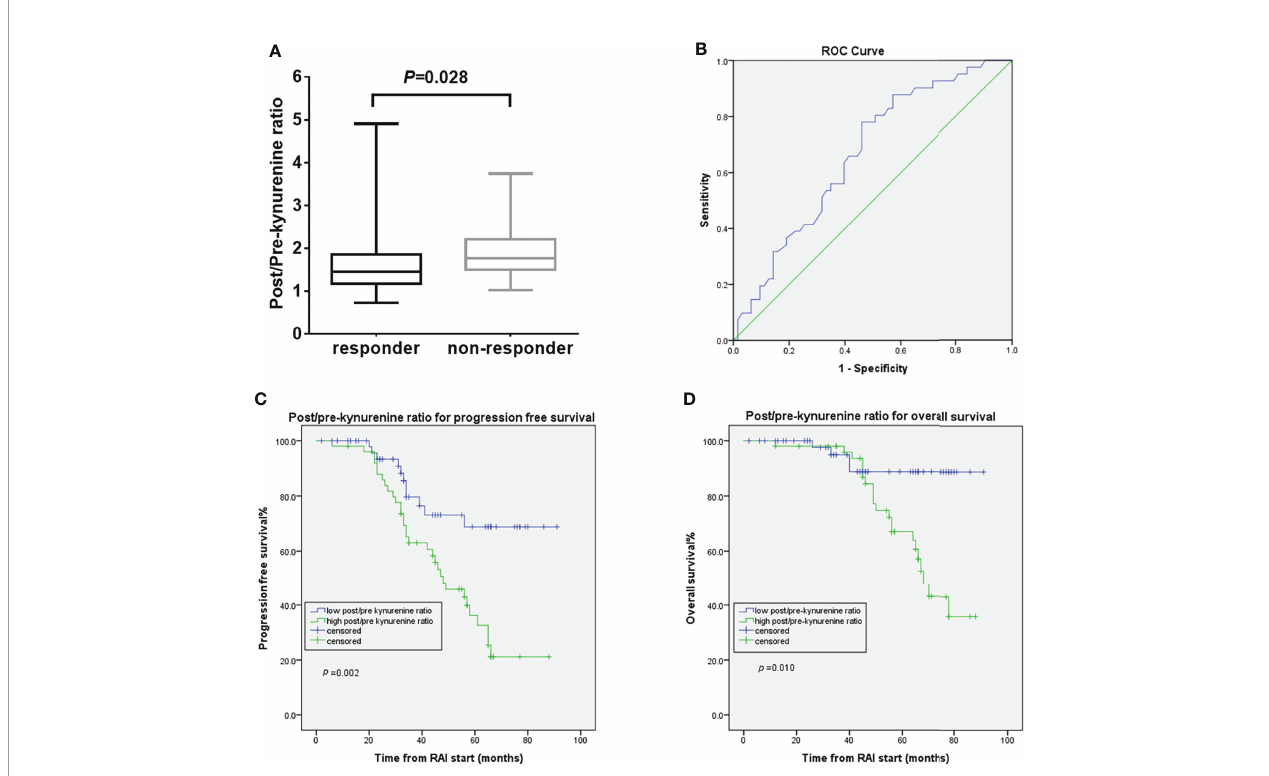
FIGURE 3 | Post/pre-kynurenine ratio and treatment outcomes. (A) the post/pre-kynurenine according to the response to RAI treatment (B) ROC curve for post/ pre-kynurenine in dmDTC patients (C) PFS curves of the dmDTC patients according to post/pre-kynurenine (D) OS curves of the dmDTC patients according to